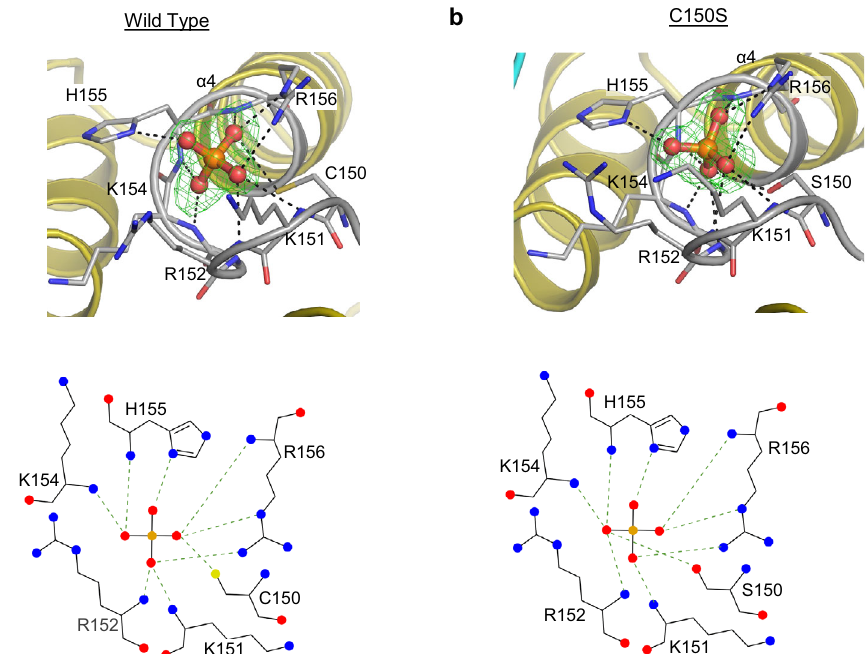
Fig. 2 Description of the Pi(A) orientation associated with crystals of freshly puri fi ed At PFA-DSP1 49 – 215 and At PFA-DSP1 49 – 150,C150S,151 – 215 . Panels ( a , b ), show the phosphate ion in stick and ball format (phosphorus is orange and oxygen in red) within a mixed stick- and ribbon-style rendition of the catalytic center of wild type and the C150S protein constructs, respectively (nitrogen is blue, sulfur is yellow). The omit Fo-Fc electron density maps, contoured at 5 σ , are shown in green mesh; broken black lines show polar contacts. Corresponding ligand – protein interactions created by Ligplot + are shown below each graphic. Source data are provided for ( a , b ) as PDB accession codes 7MOK and 7MOD, respectively.